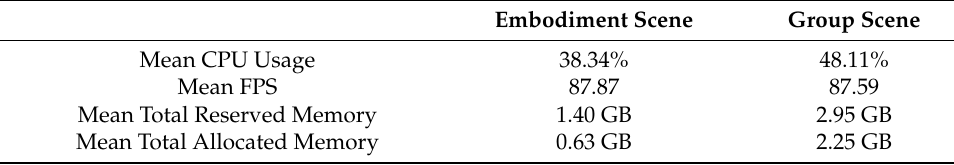
Table A2. Mean results for Test Condition